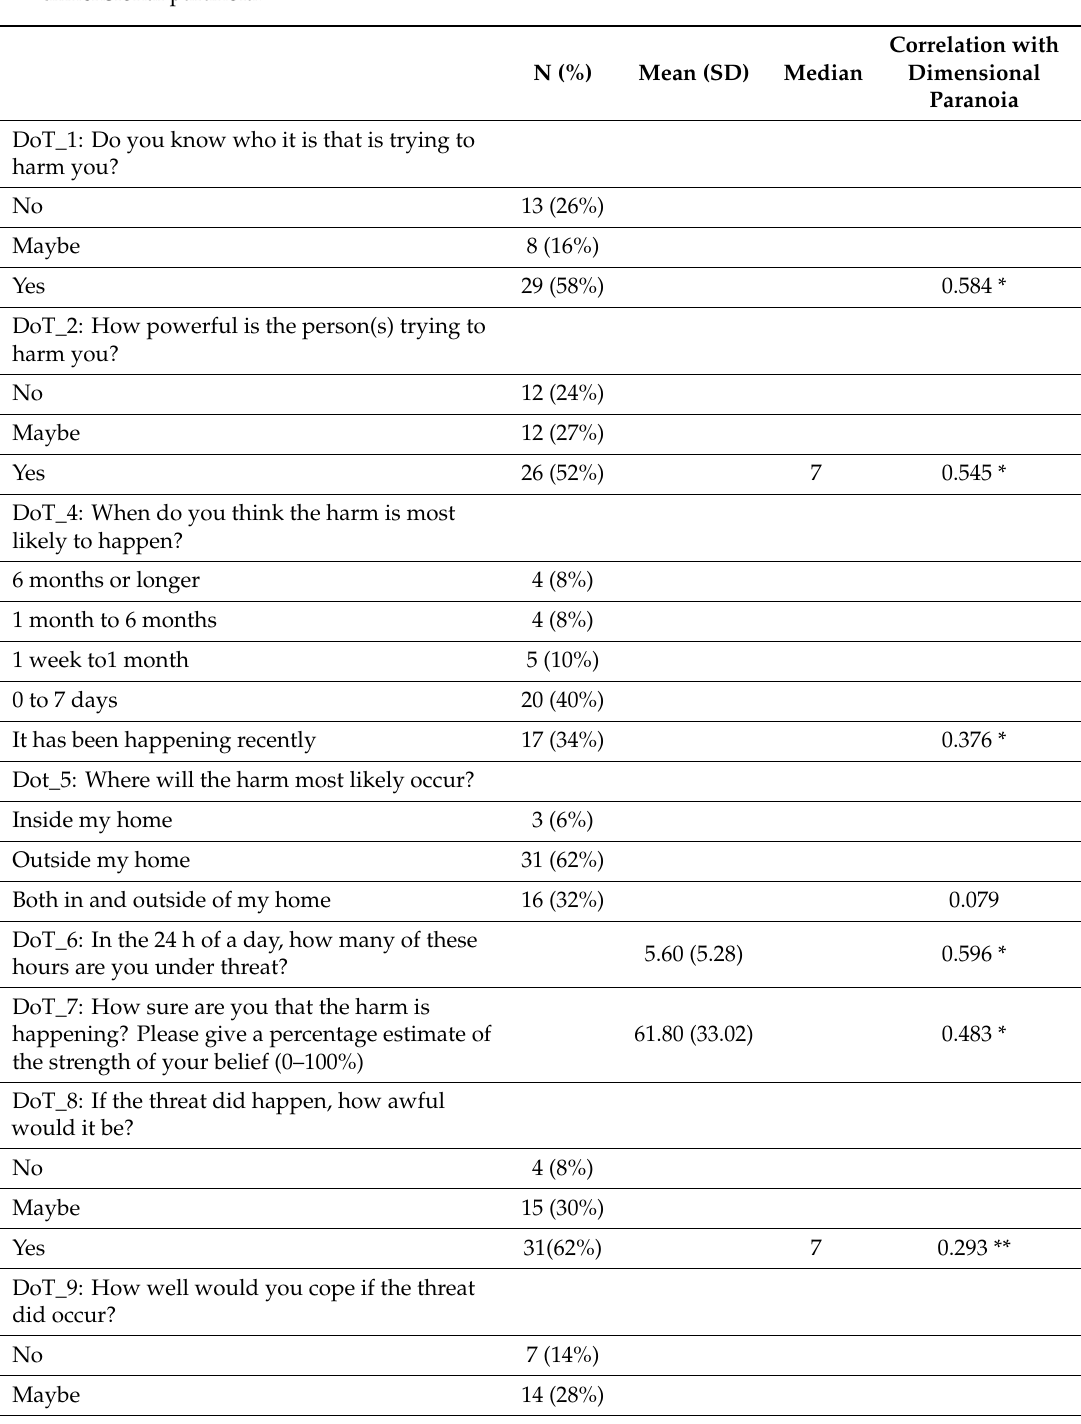
Table 1. Contents of paranoid thoughts: the Detail of Threat (DoT) descriptions and correlations with dimensional paranoia.